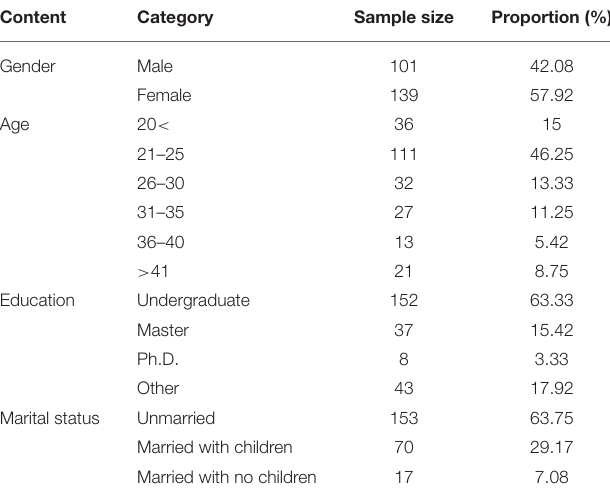
TABLE 1 | Results of descriptive statistics of the sample ( N =